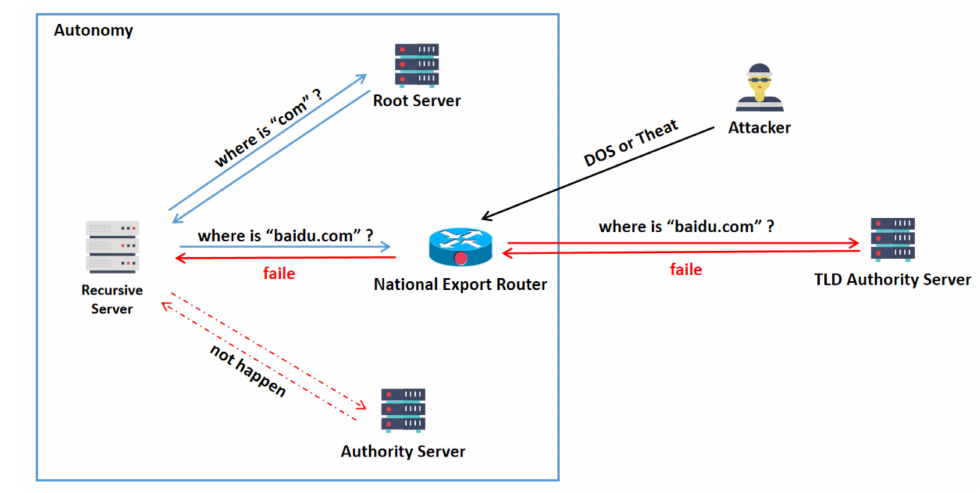
Figure 2. Isolated management